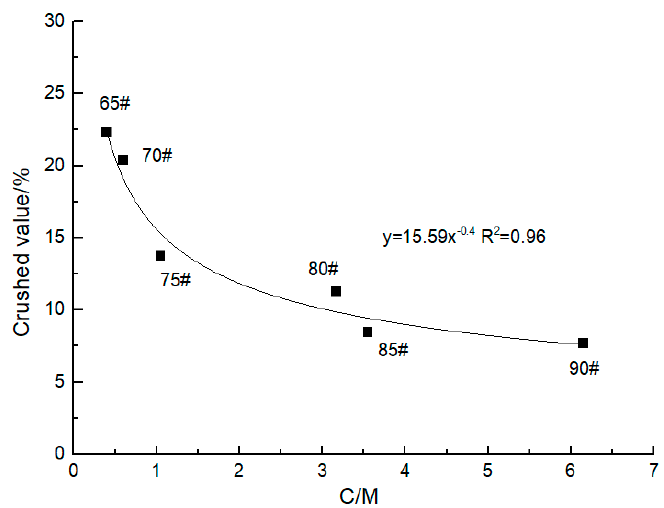
Figure 18. The relationship between C / M and the crushing value.